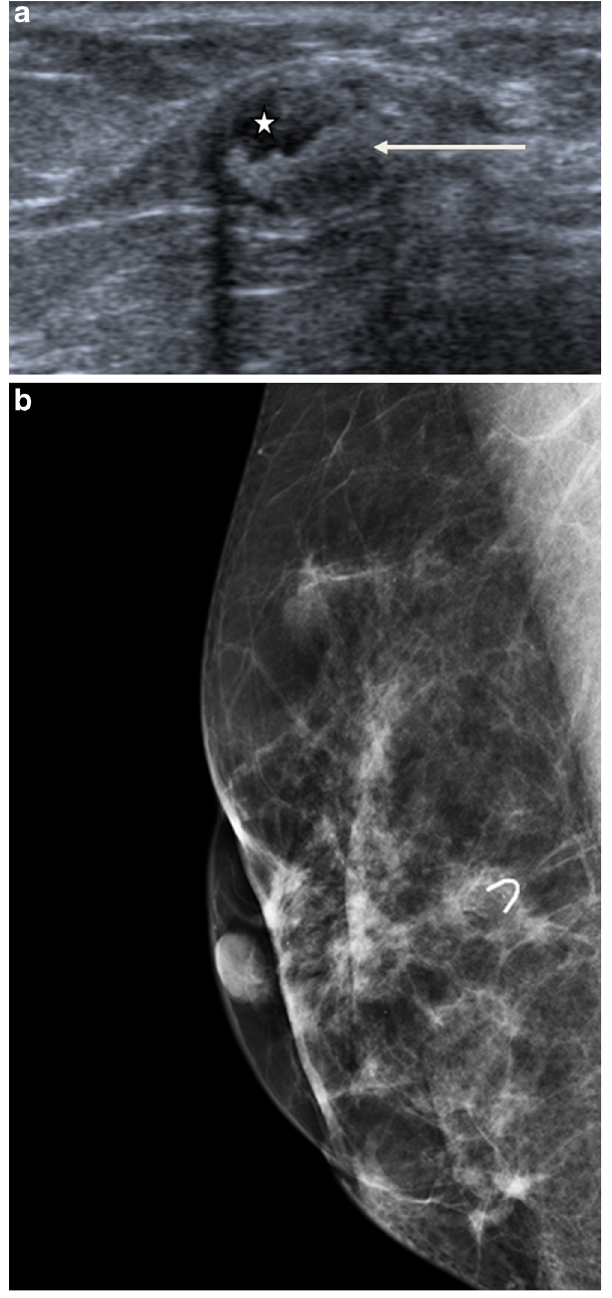
Fig. 3 Fat necrosis. a Ultrasound scan showing a complex mass composed of an echo-free fat component ( asterisk ) and an echogenic fibrous component ( arrow ). b Mammography, oblique view, showing a radiolucent formation projected over a clip